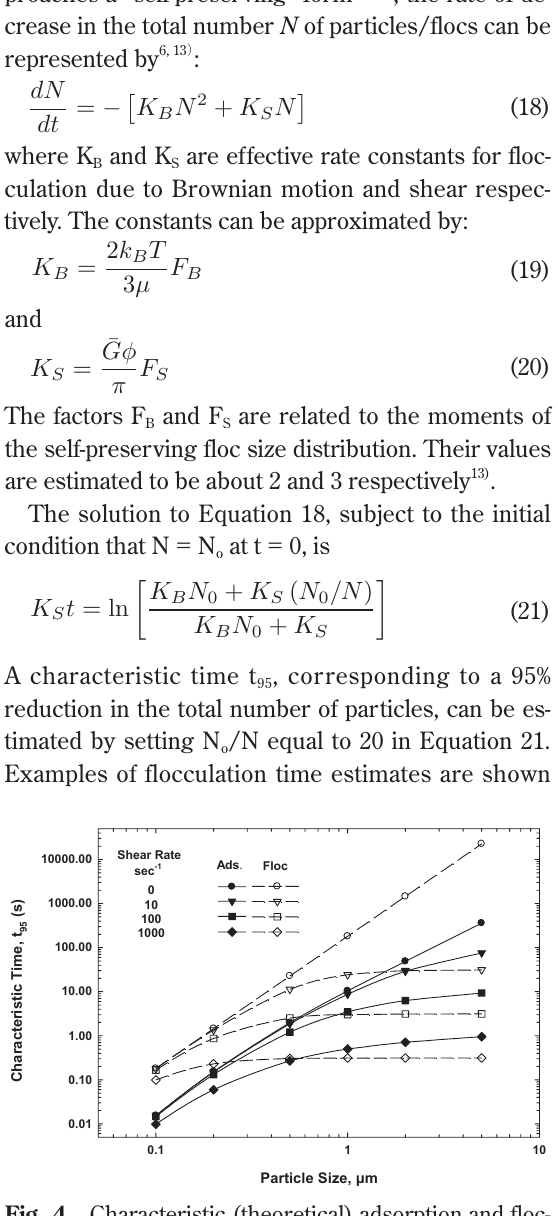
Fig. 4 Characteristic (theoretical) adsorption and floc- culation times for suspensions at 1% by volume in the presence of a 10 million molecular weight